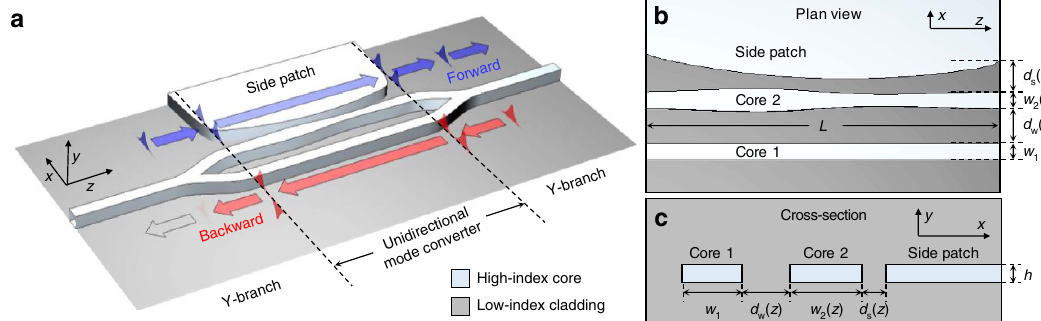
Figure 7 | Schematic of a proposed design based on lithographically generated complex effective index modulation. Device structure ( a ) in three- dimensional (3D) view, ( b ) in plan view in the x–z plane and ( c ) in cross-section in the x–y plane. In this design, the appropriately modulated inter- waveguide spacing d w ( z ), waveguide width w 2 ( z ) and waveguide side-patch spacing d s ( z ) create real and imaginary effective index profiles identical to those indicated in Fig.